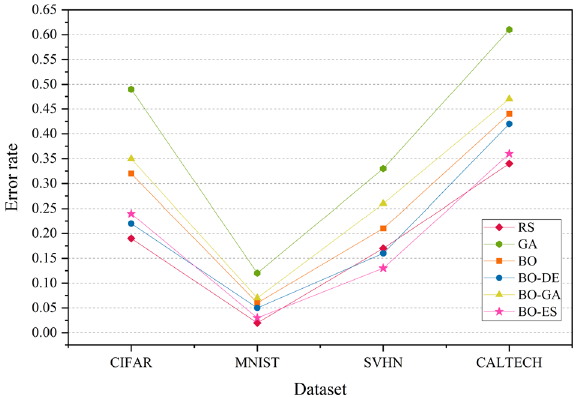
Figure 6. Test set classification error plot of an AlexNet model that uses RS, GA, a BO framework for HPO with L-BFGS, BO-DE, BO-GA and BO-ES. The figure depicts the average test error rate across the datasets— CIFAR, MNIST, SVHN and CALTECH (based on 20 iterations). The results are obtained using the Friedman test with a statistical significance of p < 0.05